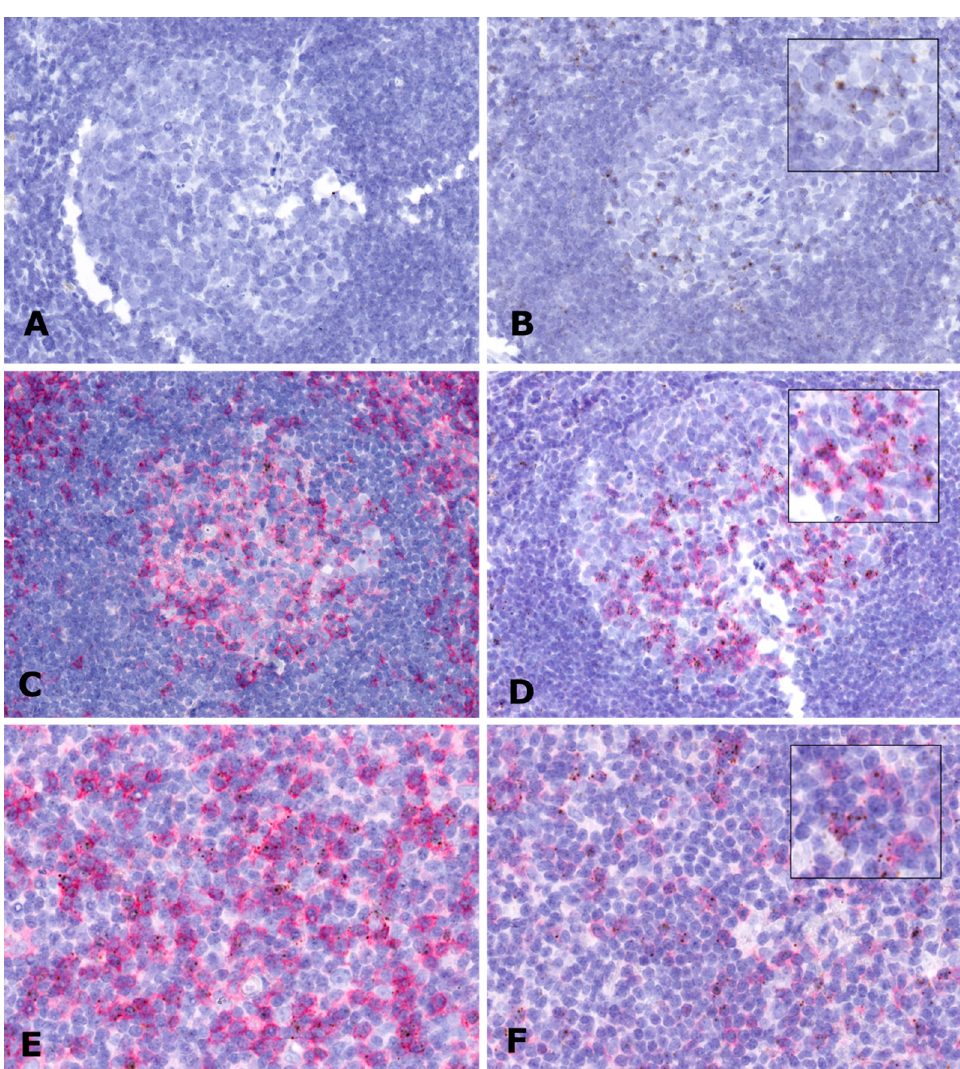
Figure 4. Intra-tissue LINC00892 localization using in situ hybridization (ISH) and